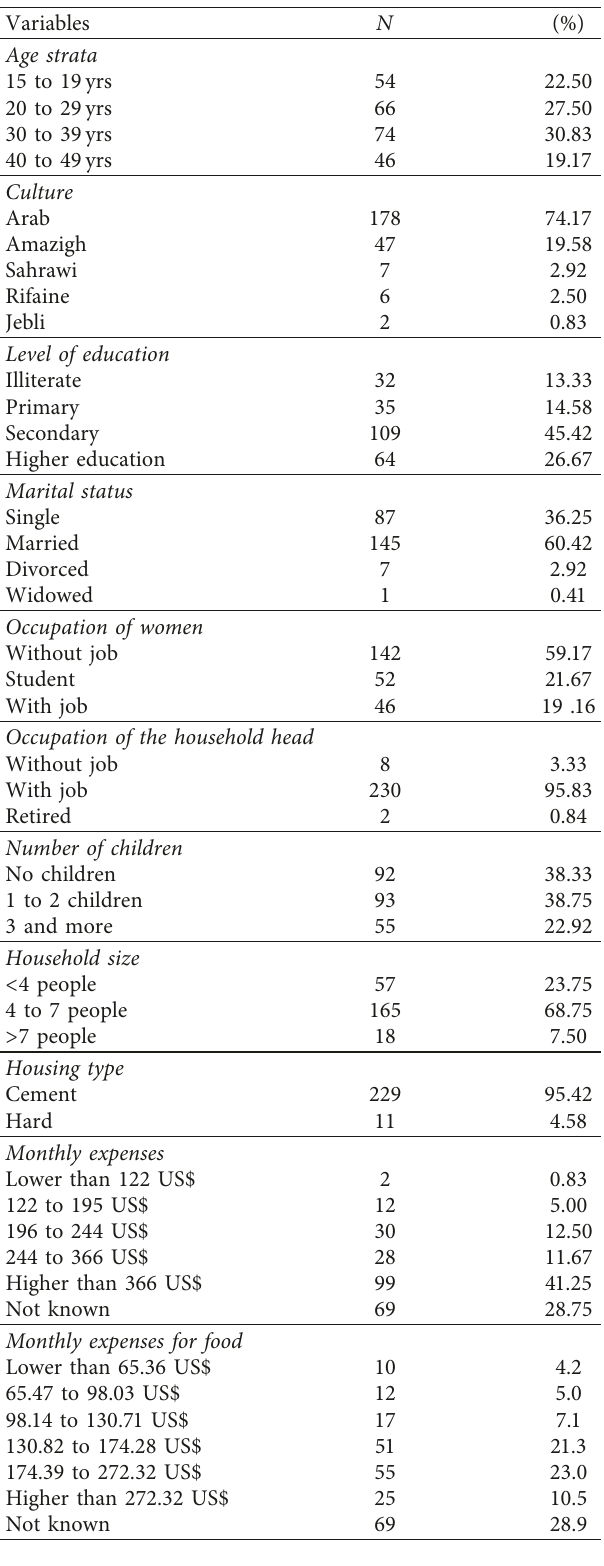
Table 1: Socioeconomic characteristics of women of childbearing Table 2: Characteristics of anthropometric parameters of the studied